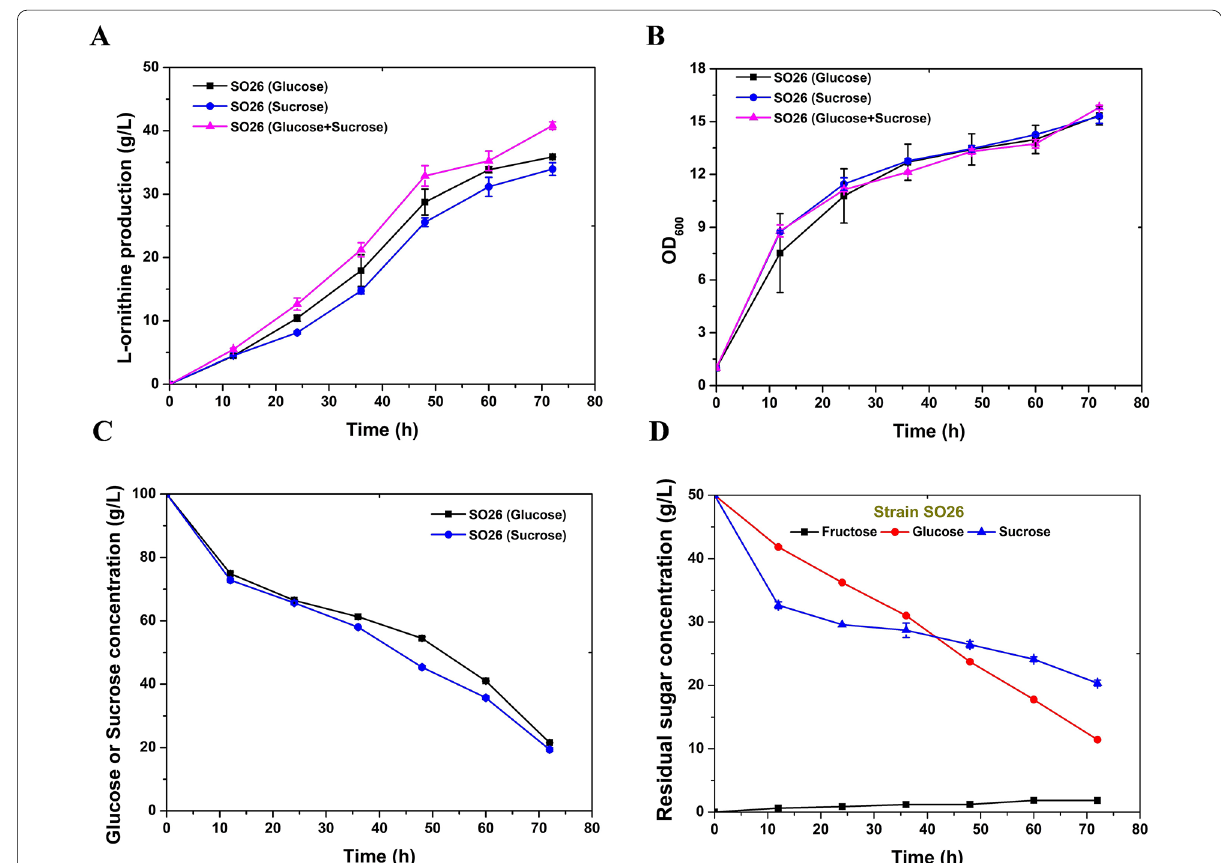
Fig. 2 Shake-flask fermentation evaluation of C. glutamicum SO26 on different carbon sources. A l -Ornithine concentration in the fermentation liquids of C. glutamicum SO26 cultivated on glucose (solid black square), sucrose (solid blue cycle), and glucose plus sucrose (solid pink triangle). B Cell growth of C. glutamicum SO26 cultivated on glucose (solid black square), sucrose (solid blue cycle), and glucose plus sucrose (solid pink triangle). C Sugar consumption of C. glutamicum SO26 cultivated on glucose (solid black square), sucrose (solid blue cycle). D Sugar consumption of C. glutamicum SO26 cultivated on glucose plus sucrose. Black square represents fructose, red cycle represents glucose, and blue triangle represents sucrose. Data are averages and standard deviations from three independent experiments